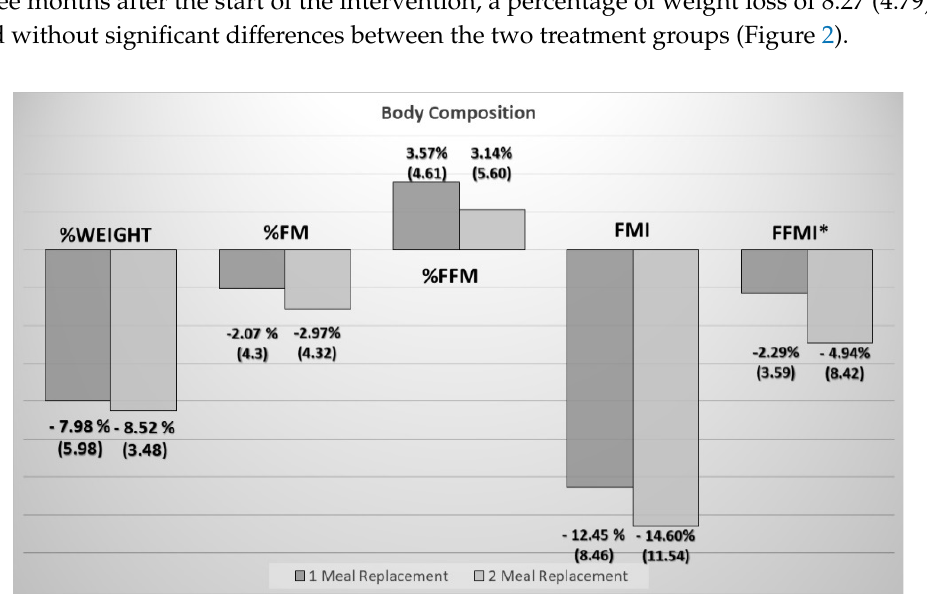
Figure 2. Comparison of changes over three months (percentage of change in the Y axis) in anthropometry and body composition between two groups. %FM: percentage fat mass from total weight; %FFM: Percentage Fat-Free Mass from total weight; FFMI: Fat-Free Mass Index; FMI: fat mass index (* p -value < 0.05).